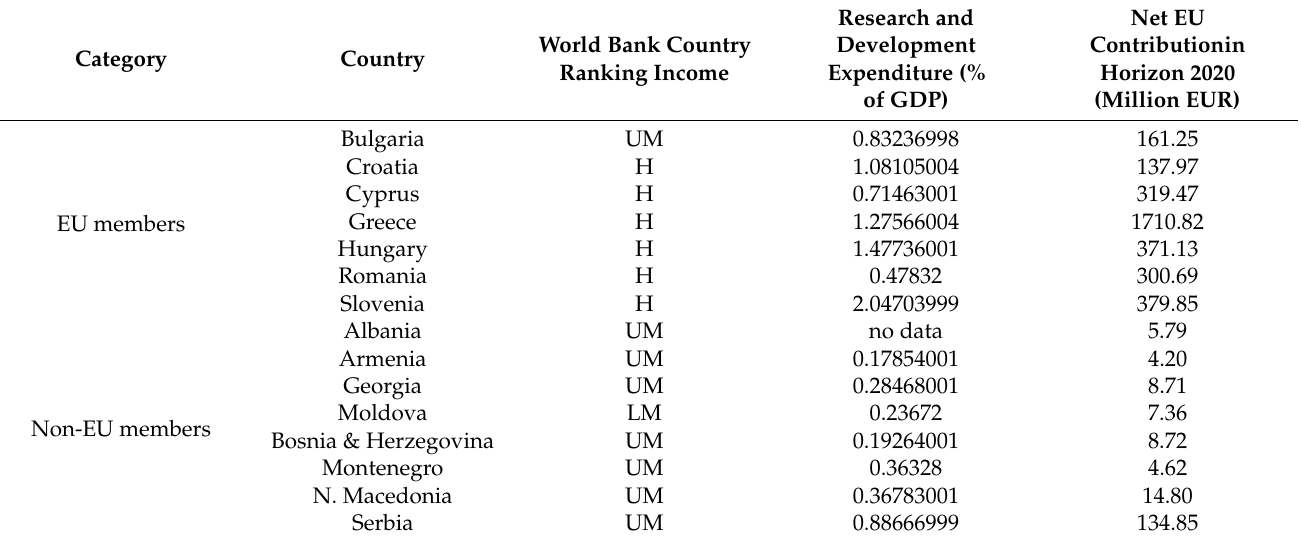
Table 4. NI4OS-Europe partner countries in 2019: World Bank Country Ranking, research and development expenditure (percent of GDP) and the net contribution in Horizon